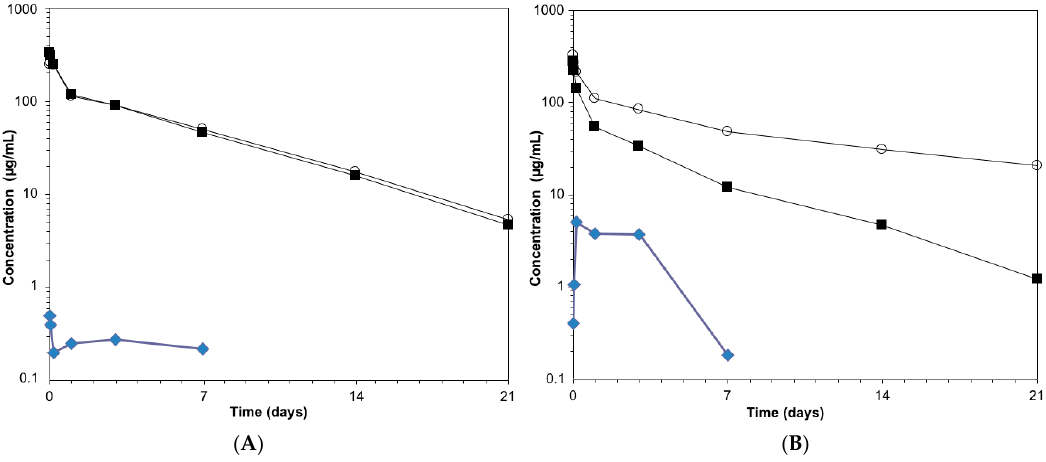
Figure 5. ( A ) PK profile of brentuximab- 7 ; ( B ) PK profile of Adcetris ® . Open circle = total antibody (by ELISA); solid square = total conjugated antibody (by ELISA); blue diamond = free MMAE (by LC-MS).